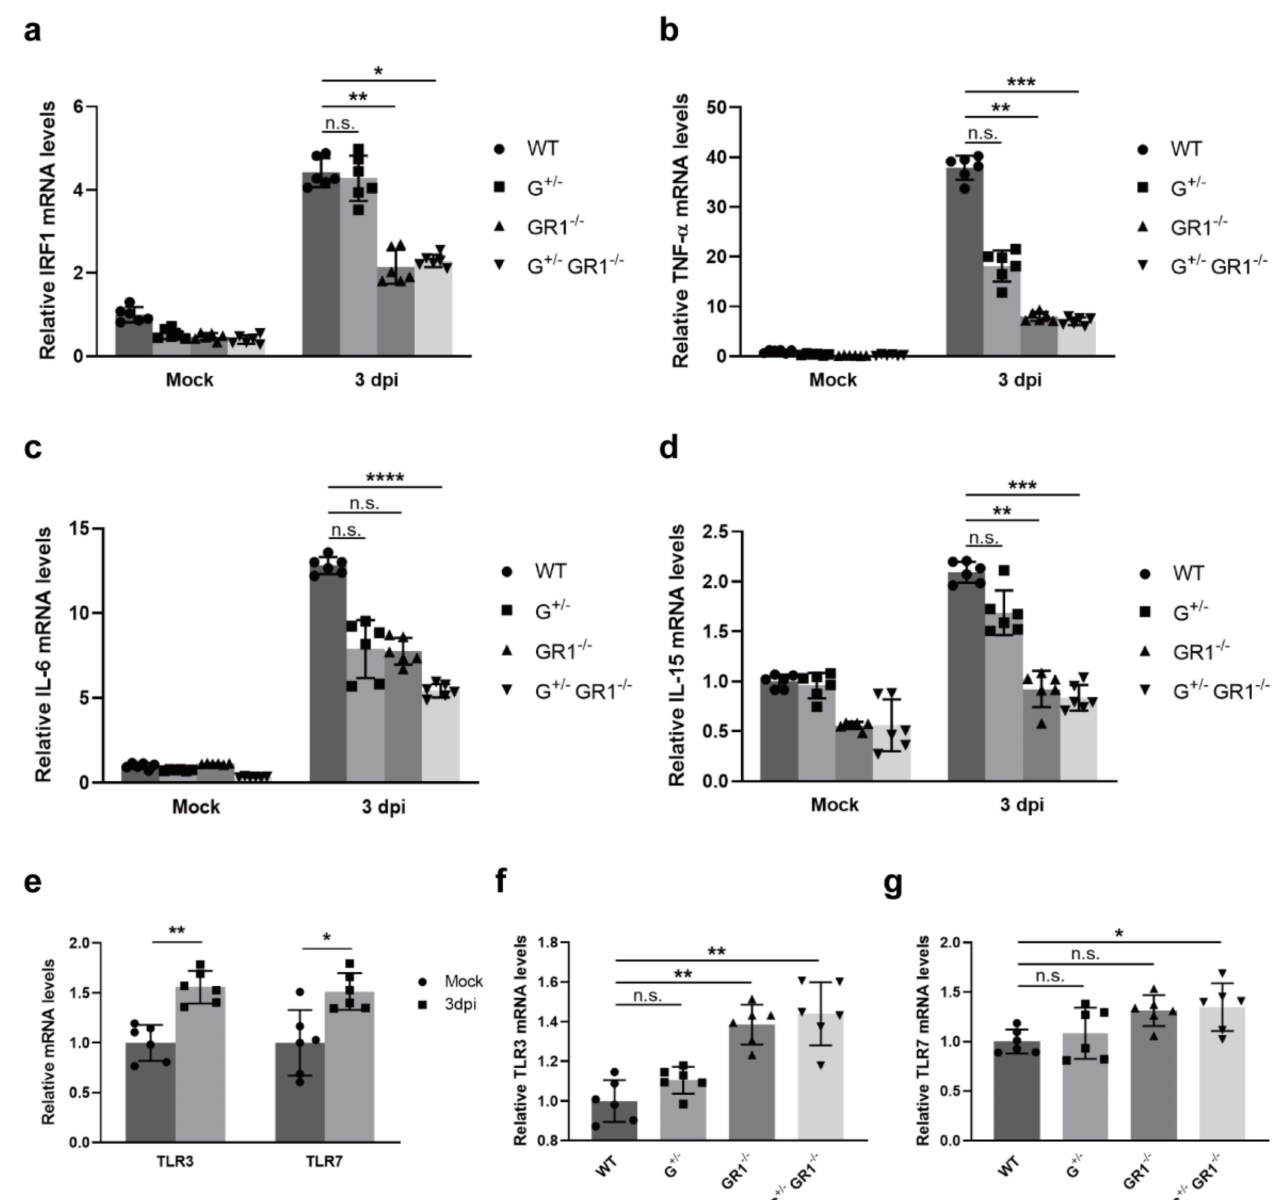
Figure 6. Downregulation of IFN- γ -induced cytokines in IFNG - and IFNGR1 -knockout Vero cell lines upon HCoV-OC43 infection. ( a – d ) Relative IRF-1 ( a ), TNF- α ( b ), IL-6 ( c ), and IL-15 ( d ) expression levels in G +/ − , GR1 − / − , and G +/ − GR1 − / − cell lines after HCoV-OC43 infection. IRF-1, TNF- α , IL-6, and IL-15 mRNA levels in knockout cell lines were normalized to those of uninfected wild-type controls. Results are shown as means ± SD of six independent replicates (applies to all gene-expression data, * p < 0.05; ** p < 0.01; *** p < 0.001; **** p < 0.0001; n.s., not significant). ( e ) Relative expression levels of virus recognition receptors in the Vero cell line after HCoV-OC43 infection. TLR3 and TLR7 mRNA levels in HCoV-OC43-infected Vero cells were normalized to those in uninfected controls. ( f , g ) Relative expression levels of TLR3 ( f ) and TLR7 ( g ) in G +/ − , GR1 − / − , and G +/ − GR1 − / − cell lines after HCoV-OC43 infection. TLR3 and TLR7 mRNA levels in HCoV-OC43-infected G +/ − , GR1 − / − , and G +/ − GR1 − / − cell lines were normalized to those of infected wild-type cells. We also examined whether increased virus production in IFNG - and IFNGR1 -knockout Vero cell lines caused the induction of TLR family members. Our data showed that both TLR3 and TLR7, which are known to recognize HCoV-OC43 invasion [35], were